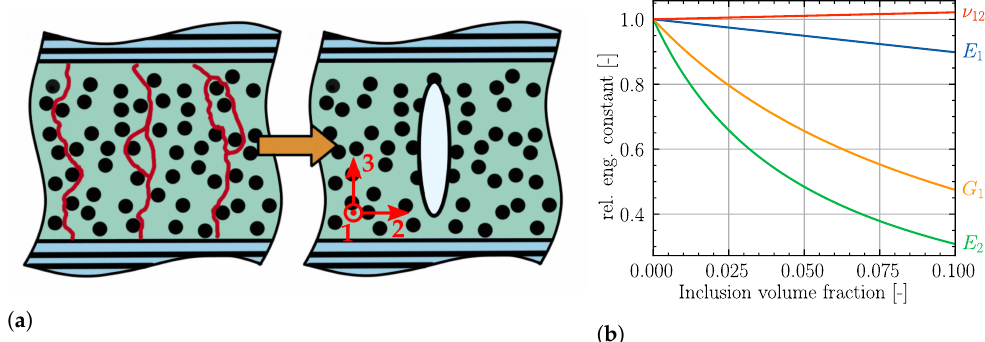
Figure 4. Representation of off-axis cracks in one ply ( a ) looking in fiber direction. The crack path is often not straight and can branch or merge. Therefore, an oblate ellipsoid is chosen as a single inclusion shape to compute the homogenized effect of these cracks. The effect of this inclusion is shown in ( b ) with the aspect ratios of 100,1,10 in 1,2,3-direction, respectively.